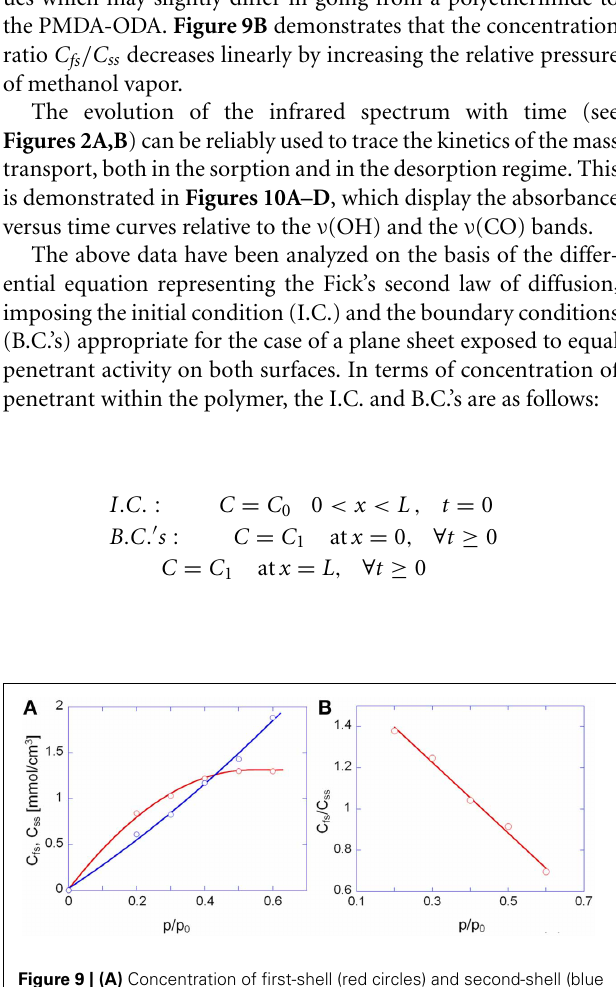
Figure 9 | (A) Concentration of first-shell (red circles) and second-shell (blue circles) methanol as a function of p / p 0 . (B) Concentration ratio of first-shell to second-shell species as a function of p / p 0 . In (A) the continuous lines are a guide for the eye.